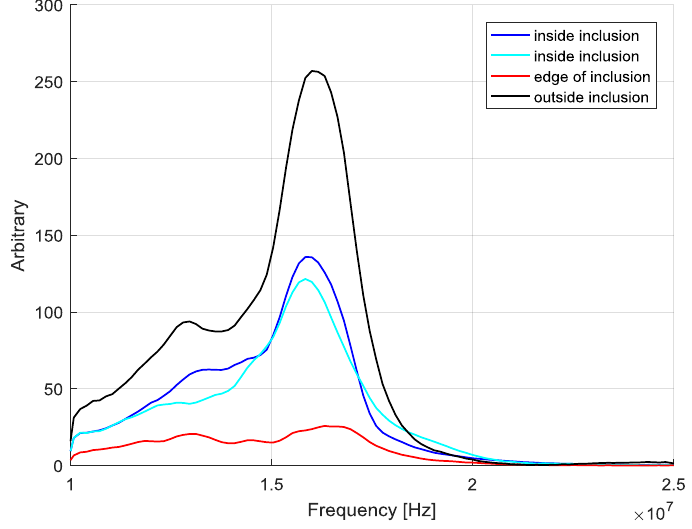
Figure 3. The frequency spectrum of the four signals shown in Figure 2.